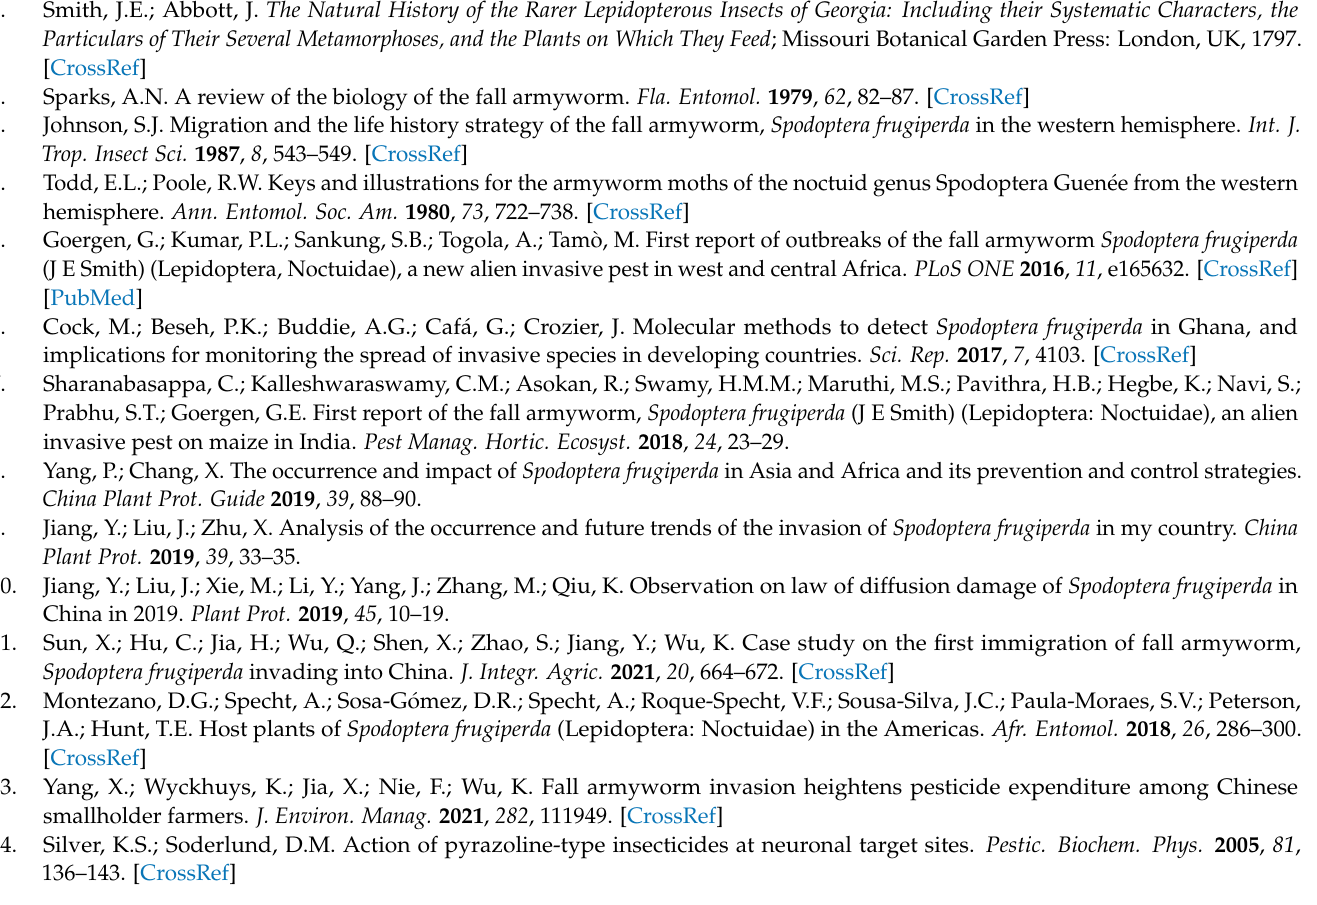
Table S5: α diversity indices of gut bacterial communities in different